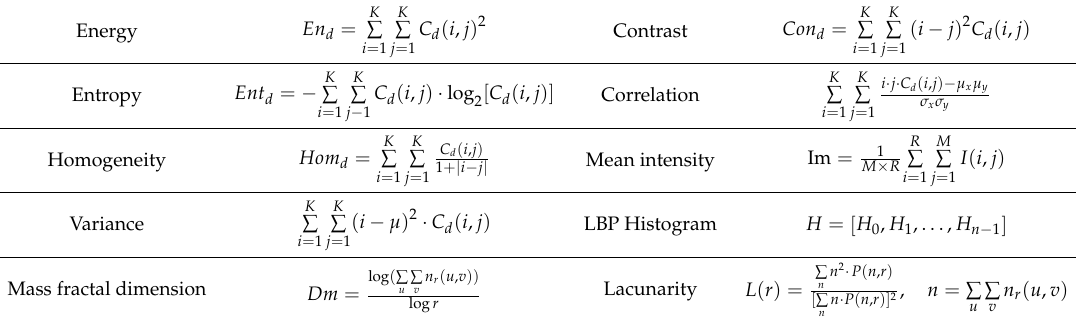
Table 2. Analyzed